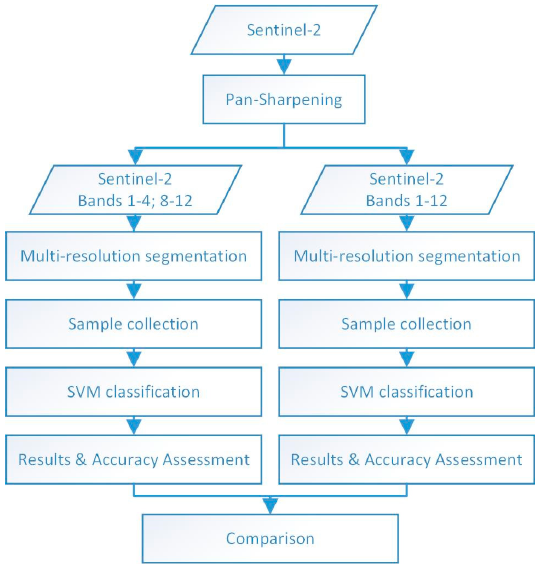
Figure 2. Methodology used in this study.